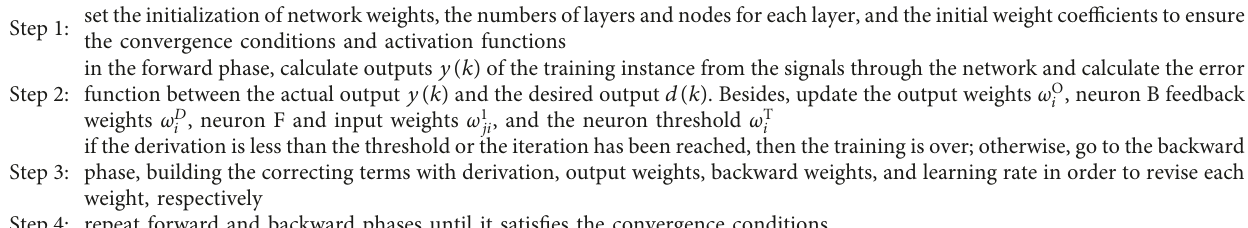
Table 1: FCNN model parameter learning.